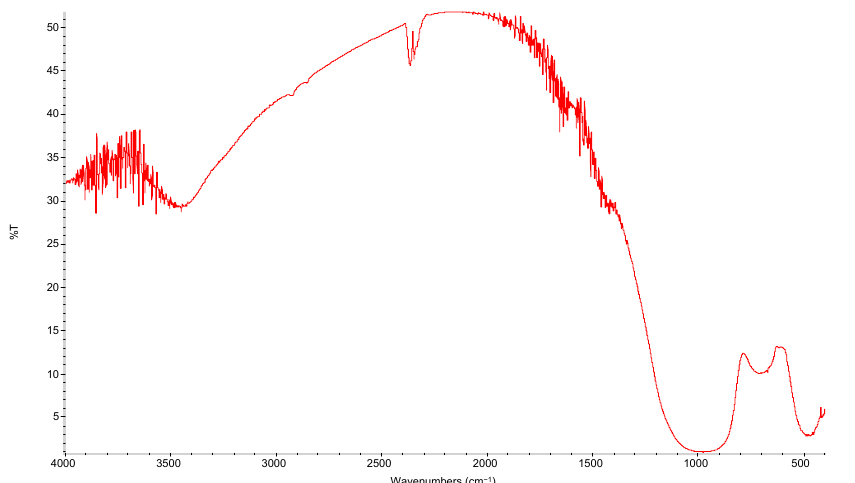
Figure 5. Infrared spectrum of cupola slag.